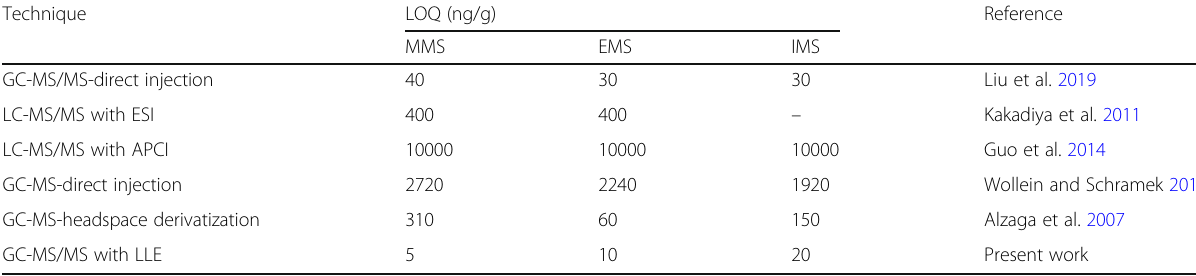
Table 5 LOQ comparison of MMS, EMS, and IMS with published methods